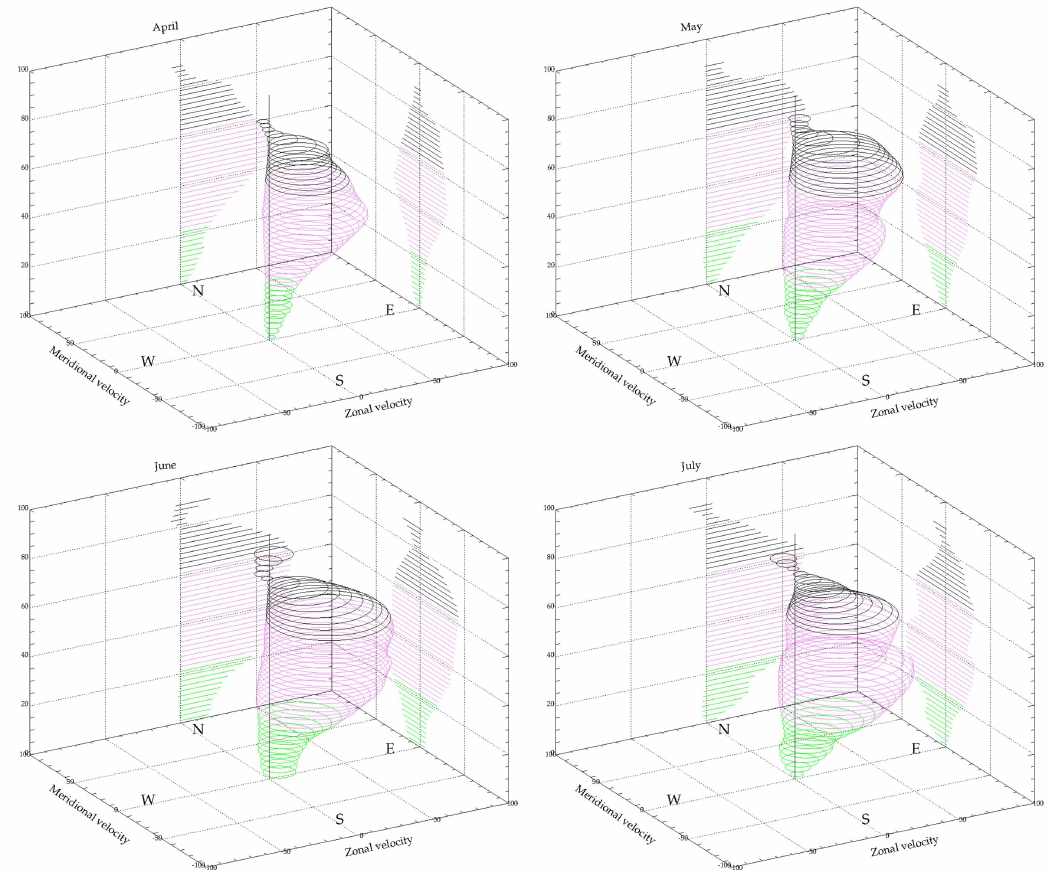
Figure 8. Blocking diagrams of April, May, June, and July based on averaged wind profiles around the new moon period. Blocking regions from 2 to 20 km of altitude are in green, representing the typical winds of the troposphere. In purple, blocking regions from 22 to 60 km, representing the stratosphere. In black, blocking regions from 62 to 90 km, representing the